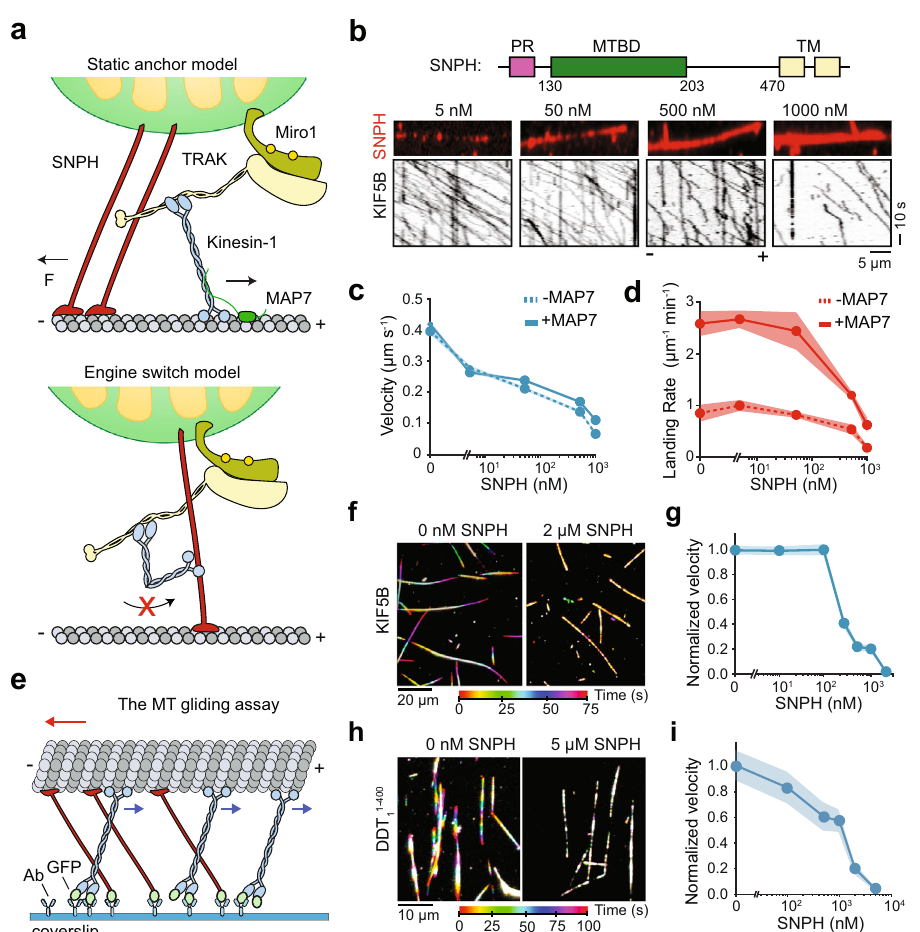
Fig. 7 | SNPH stalls MT gliding driven by kinesin and dynein motors. a Static anchor, and engine switch models for SNPH-mediated stalling of mitochondrial transport. b (Top) Domain organization of human SNPH (MTBD: MT-binding domain, PR: proline-rich domain). (Middle) SNPH decorates surface-immobilized MTs. (Bottom) Representative kymographs of kinesin motility in the presence of increasing concentrations of SNPH. The assays were conducted in 10nM MAP7. c TheaveragevelocityofkinesinonSNPH-decoratedMTsinthepresence(±s.e.m., n = 98, 158, 95, 58, and 20 from left to right) and absence of 10nM MAP7 ( n = 115, 191, 154, 93, and 59 from left to right). d The landing rate of kinesin onto SNPH- decorated MTs in the presence and absence of 10nM MAP7 (mean ± s.e.m., n = 9 MTsforeachcondition,threeindependenttrials). e SchematicoftheMTglidingby kinesin motors. Motors were fi xed on the glass surface from their tail through a